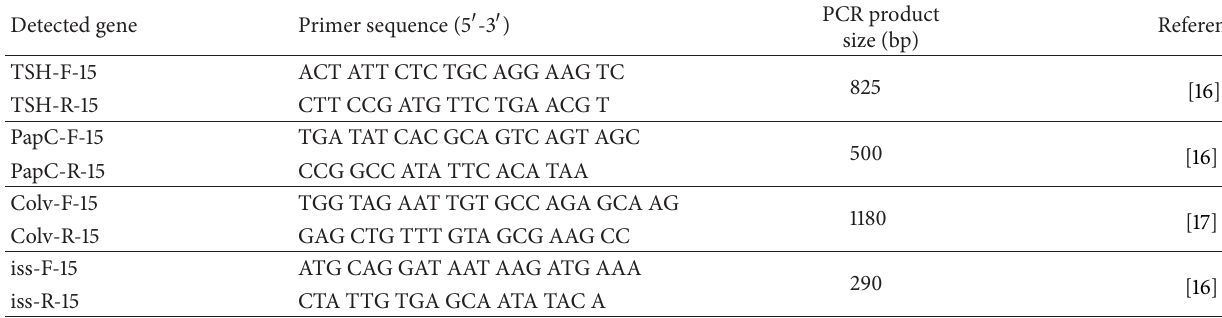
Table 1: Showing primers that were used in PCR